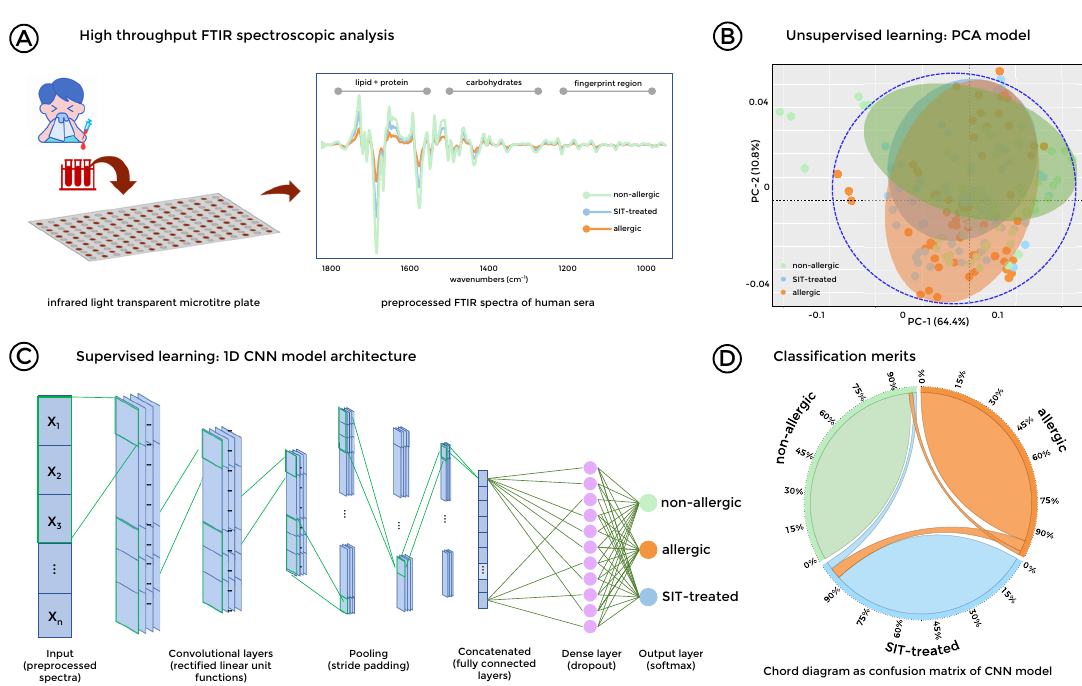
Figure 5. Machine learning empowered Fourier-Transform Infrared (FTIR) spectra from sera stratifies healthy, allergic, and SIT-treated subjects. ( A ), Succinct workflow for spectroscopic measurements with pre-processed FTIR spectra. Color codes: green: non-allergic donors; orange: allergic patients; blue: SIT-treated patients. ( B ), Unsupervised learning: Principal component analysis (PCA) score plots showing PC-1 and PC-2 within 95% confidence ellipse. ( C ), Supervised learning: Convolutional Neural Network (CNN) model for classification of FTIR spectra of human sera from non-allergic, allergic, and SIT-treated patients. It incorporates convolutional layers for spectral feature extraction and fully connected layers with dropout operations employed in dense layers as an output layer of size 3 for classification of respected groups, which is activated by softmax function. ( D ), classification merits: confusion matrix results based on the pooled test data represented as a chord diagram to display the inter-relationships within di ff erent